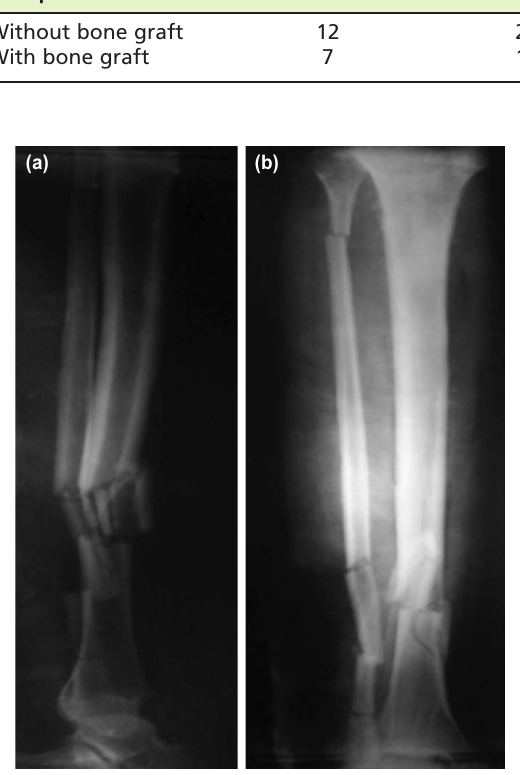
(a) Lateral and (b) anterior posterior plain radiograph of Fig. 1: open fracture of the tibia.